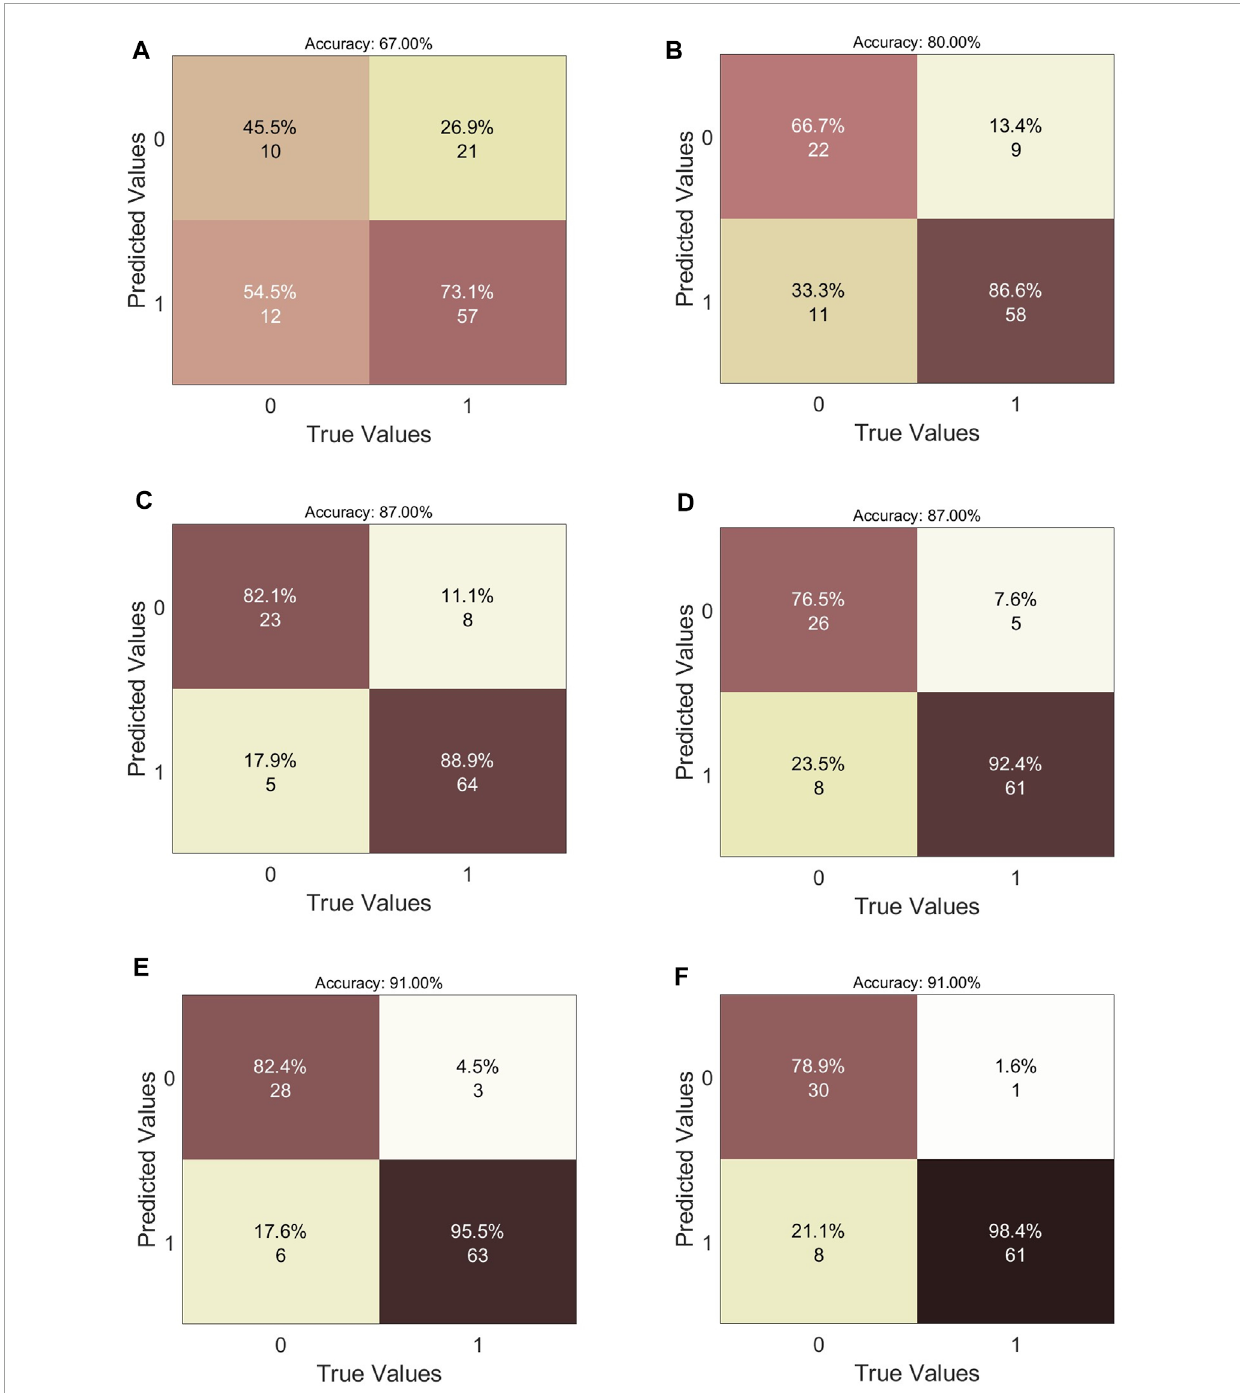
FIGURE 5 Analysis of classifiers performance. Confusion matrices of the six ML models for N train = 200. (A) Logistic Regression. (B) k-Nearest Neighbour. (C) Naive Bayes. (D) Decision Tree. (E) Artificial Neural Network. (F) Support Vector Machine.